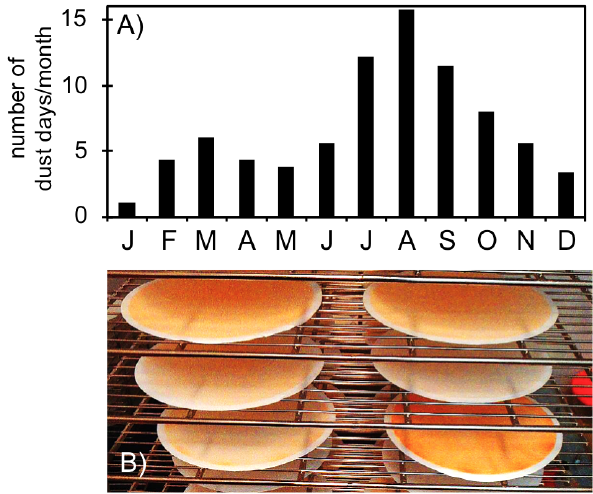
Figure 1. Saharan dust observations in Izaña. (a) Frequency of dust events ( > 10µgm − 3 ) in Izaña in the period 1987–2014. (b) Batch of filters with aerosol samples collected at Izaña for illustrating their typical ochre color due to